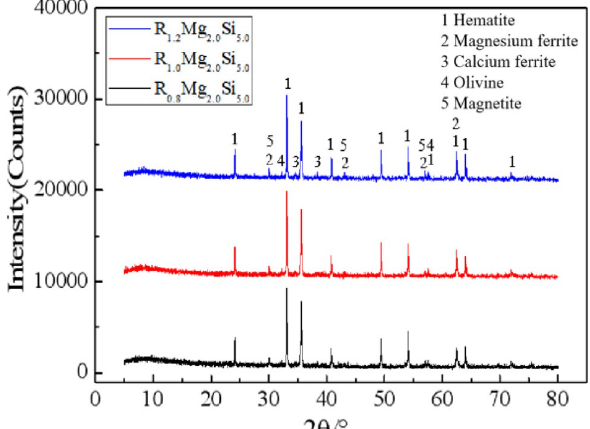
Figure 3. XRD diffraction results of beiquettes briquettes with different